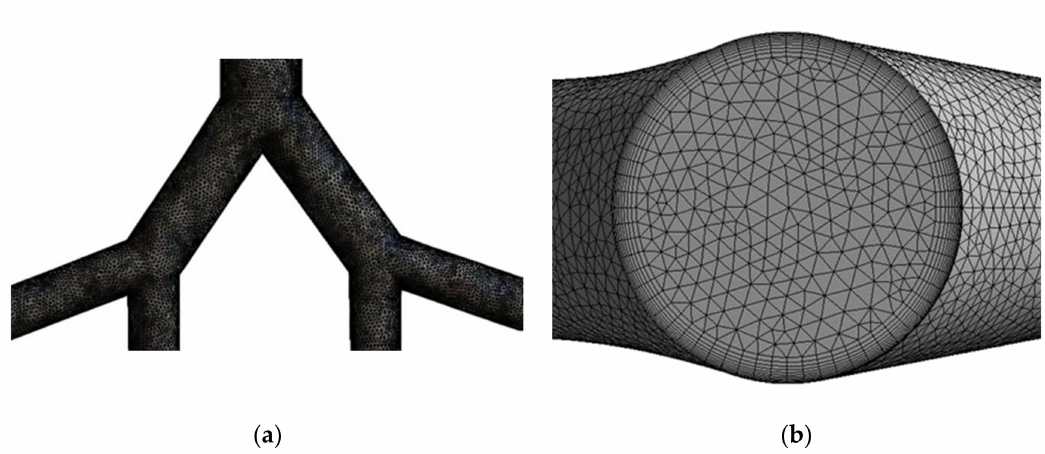
Figure 2. An overview mesh generation for symmetric lung model. ( a ) The mesh resolution of lung airway and ( b ) the refined inflation mesh near the airway